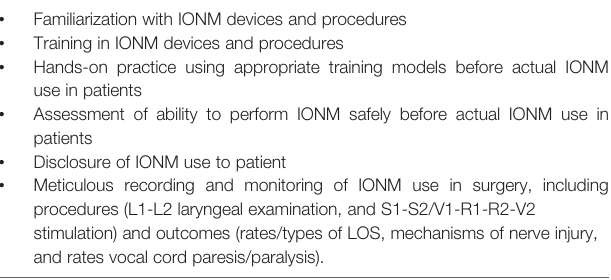
TABLE 1 | INMSG Recommendation for Implementing IONM